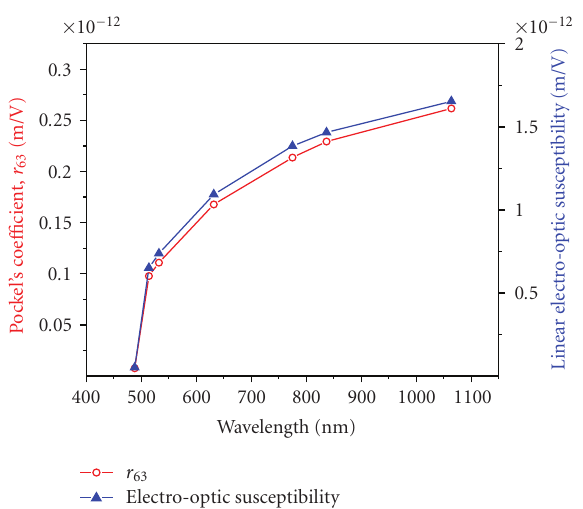
Figure 39: Electronic and nuclear energy loss for various incident electron energies in L-threonine single